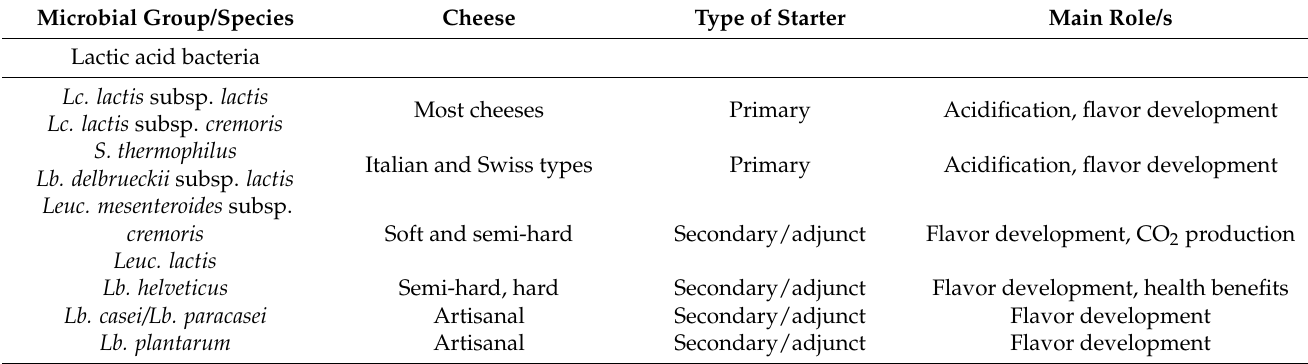
Table 1. Current common species used as “starters” in industrial dairy